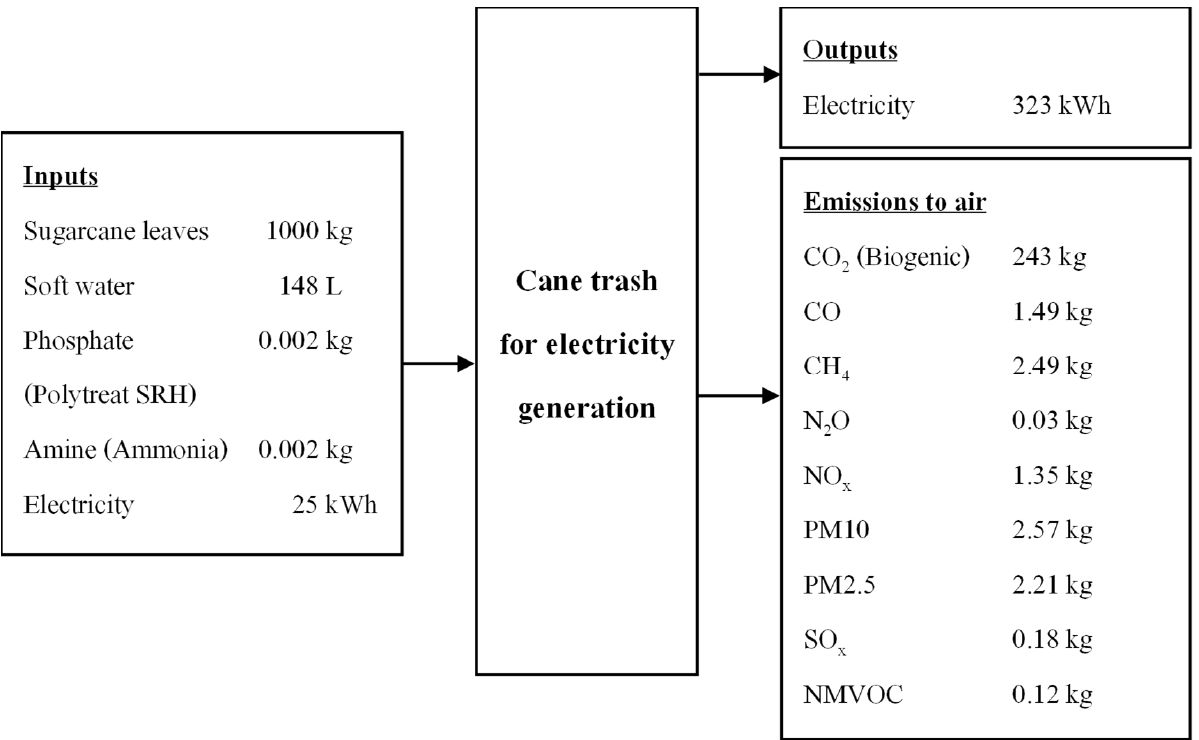
Figure A2. Inputs-Outputs for the sugarcane trash for electricity generation scenario (SL1). Remark: Emissions to air are calculated based on [43,44].